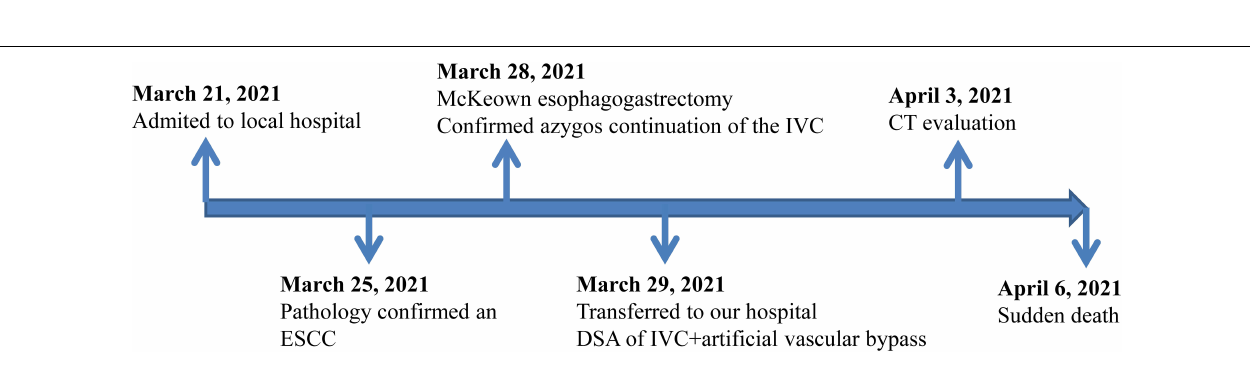
FIGURE 2 | Emergency digital subtraction angiography (DSA) of the inferior vena cava and artificial vascular bypass to reconstruct venous drainage. (A) Shows a large thrombus (yellow arrow) in the azygos vein. (B) Shows the inferior vena cava filter (blue arrow) superior to the bilateral renal vein. (C) Shows the well-located artificial vessel (red asterisk).